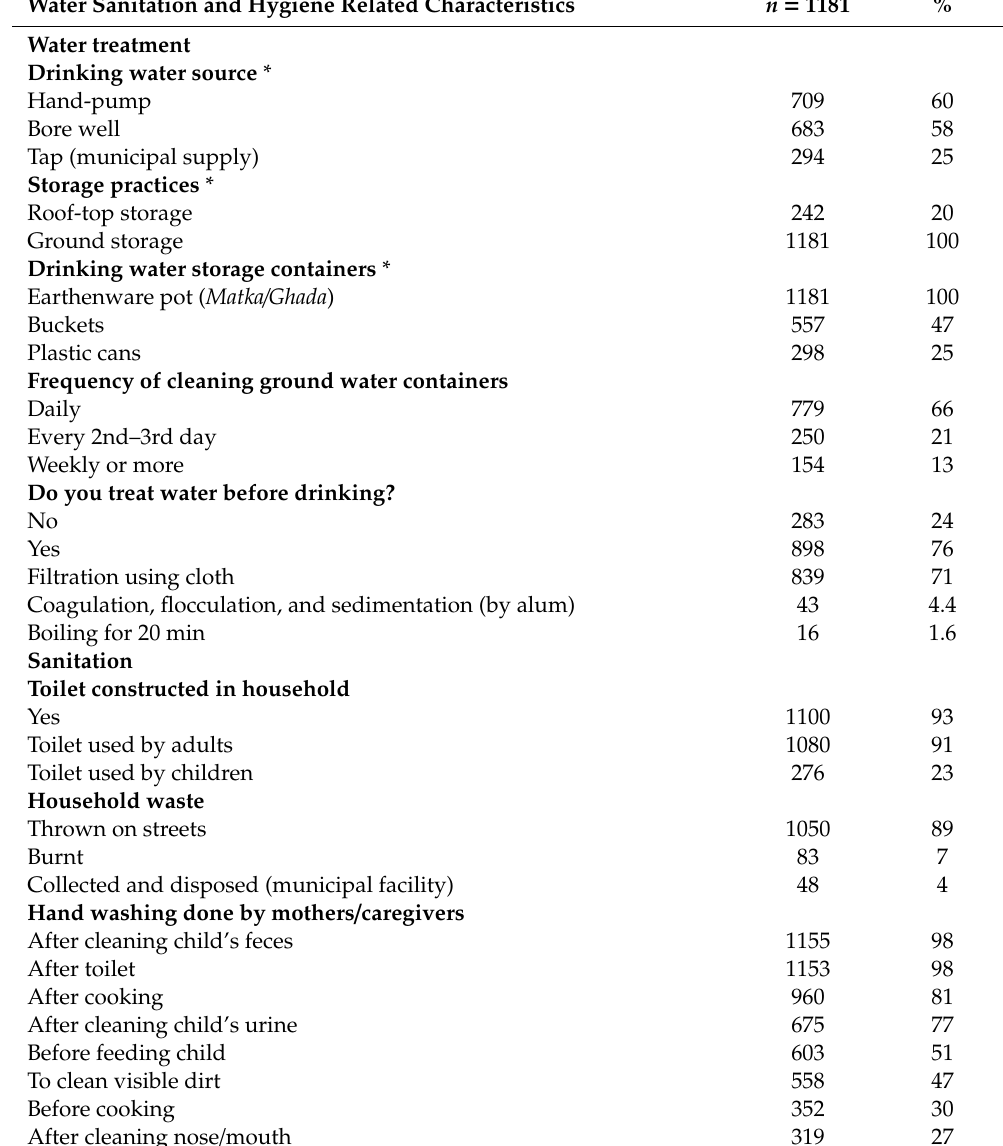
Table 2. Water sanitation and hygiene-related characteristics of 1181 the households. Water Sanitation and Hygiene Related